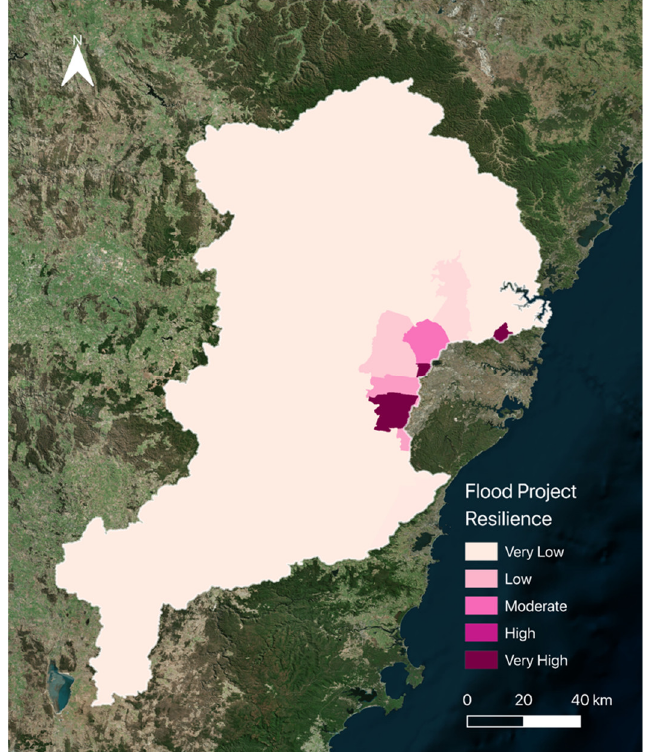
Figure 11. Flood Project Resilience after standardising using fuzzy membership processing. Resilience measured from Very Low (light pink) to Very High (dark pink).